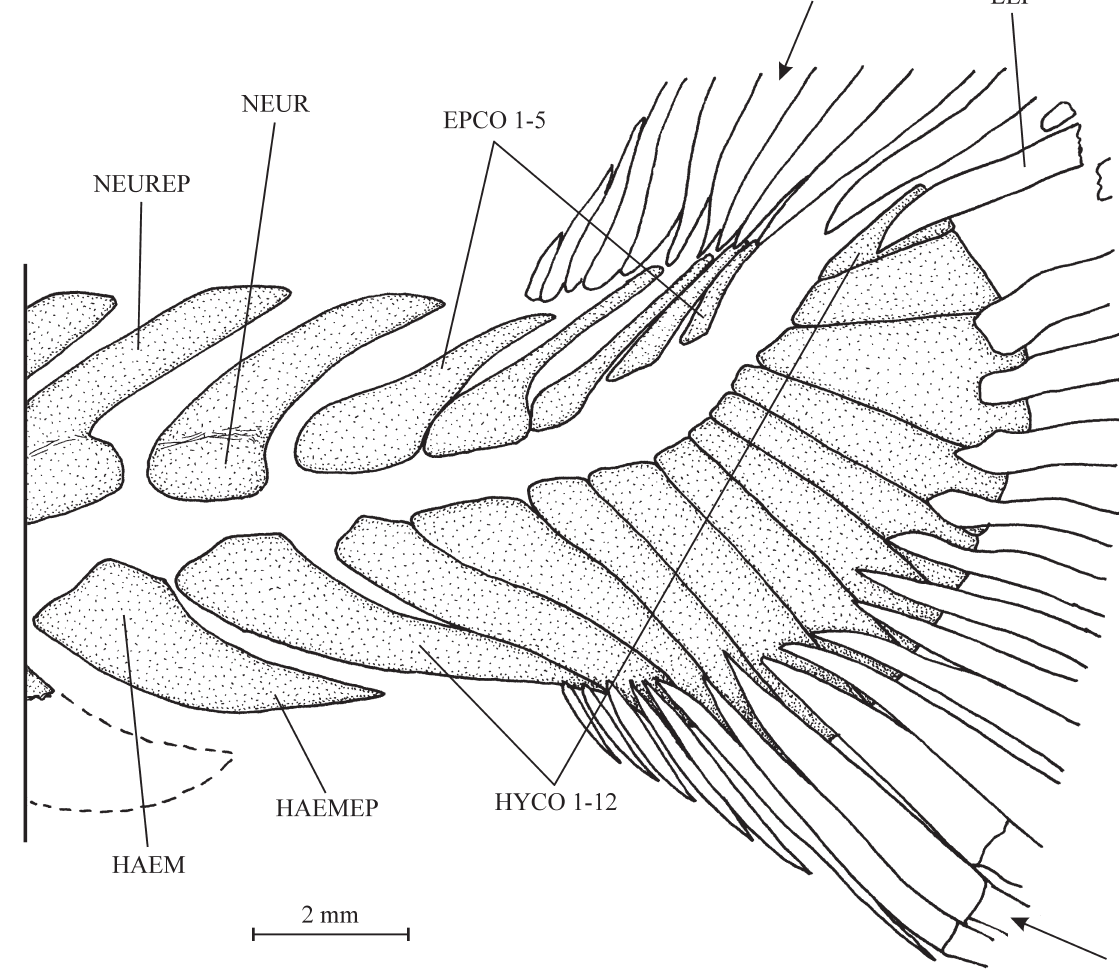
Fig. 13. Monocerichthys scheuchzeri gen. et sp. nov. Reconstruction of the caudal skeleton, based on the two faces of holotype CLC S-413a,